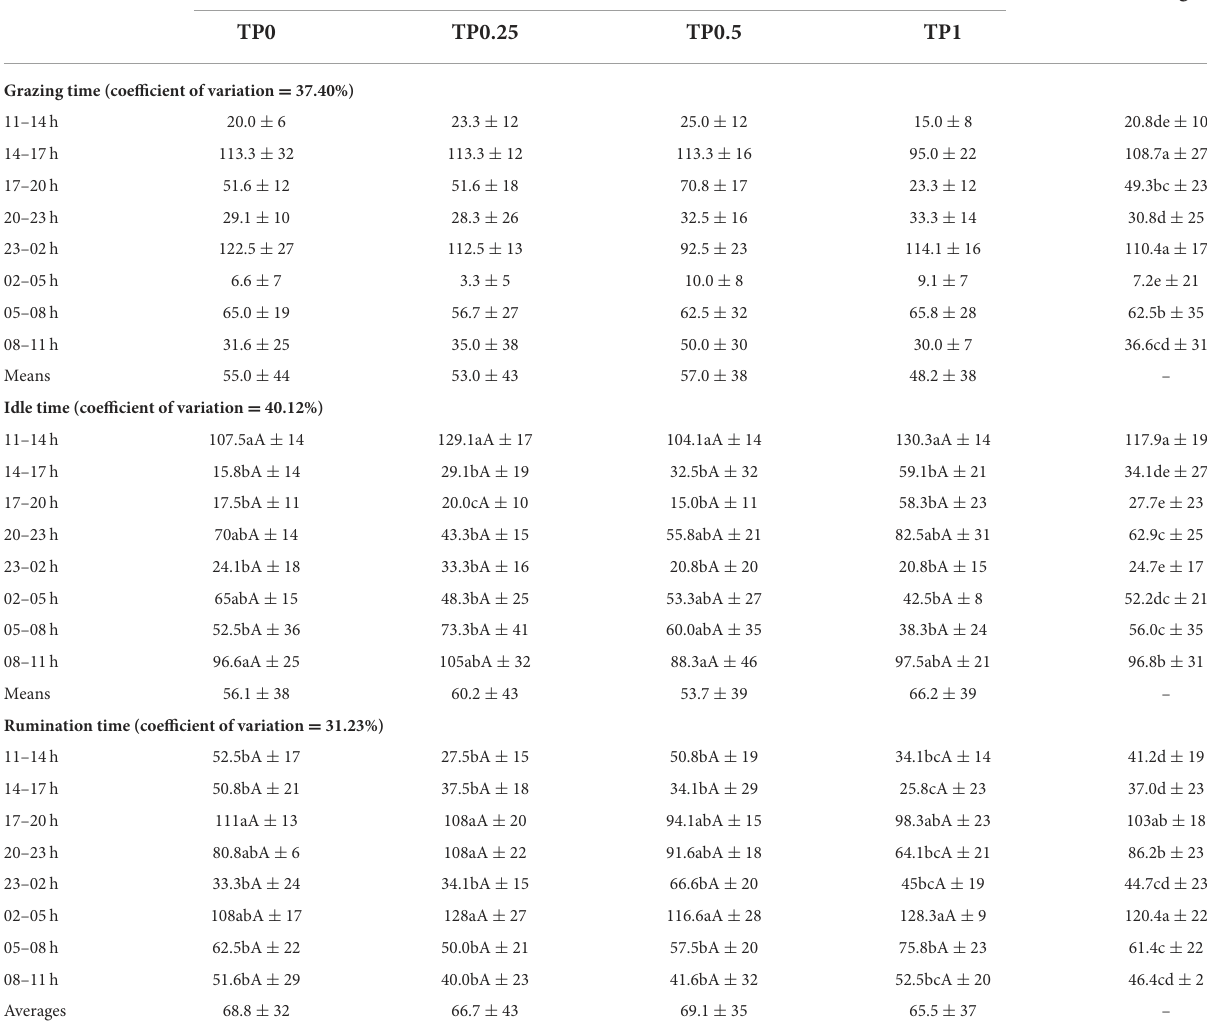
TABLE 4 Grazing, idleness, and ruminating time in female buffaloes supplemented with palm kernel cake during the less rainy season